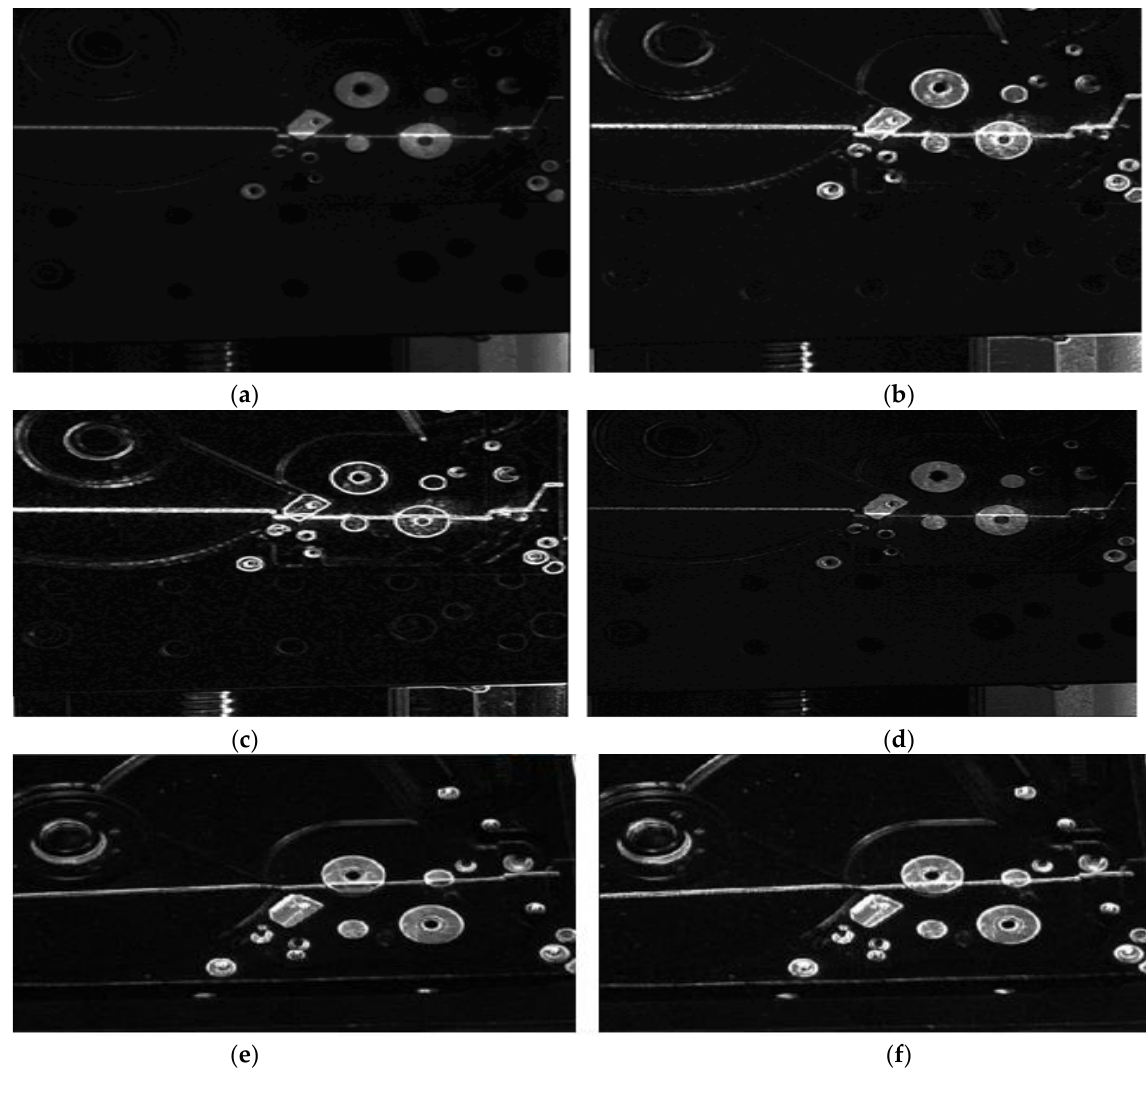
Figure 8. Image enhancement effect of hard disk substrate: ( a ) original drawing of light; ( b ) Laplacian reinforcement; ( c ) Sobel enhancement; ( d ) v = 0.5 differential enhancement; ( e ) V = 0.7 differential enhancement; ( f ) v = 0.8 differential enhancement. Table 1. Entropy and gradient values after enhanced processing by three algorithms.